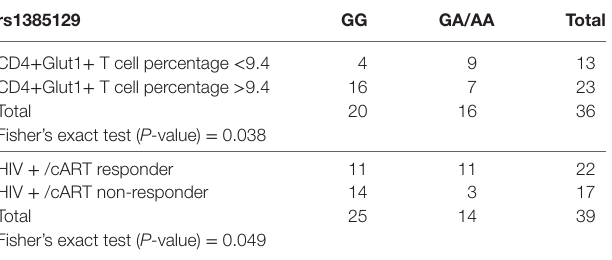
TaBle 3 | Fisher’s exact testing of rs1385129 SLC2A1 single nucleotide polymorphism allele distribution against high and normal HIV + /cART CD4 + Glut1 + T cell percentage groups, and responder and non-responder groups. rs1385129